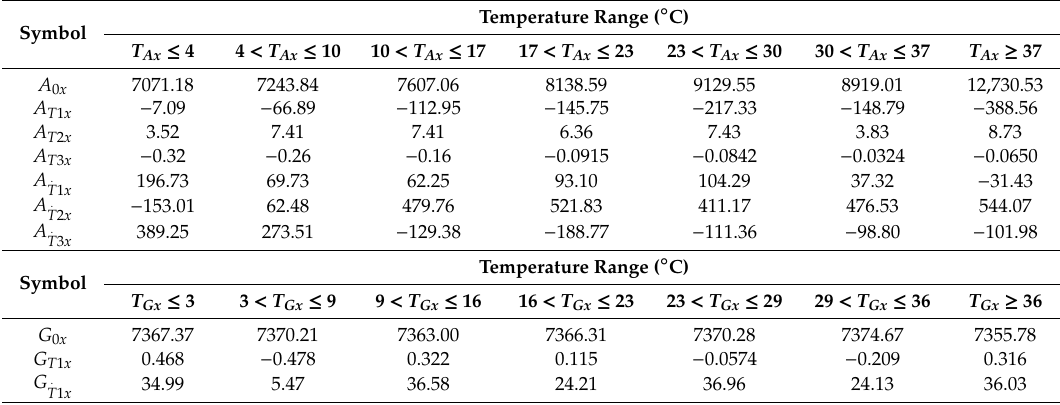
Table 4. The thermal calibration results of x -axis IMU based on method